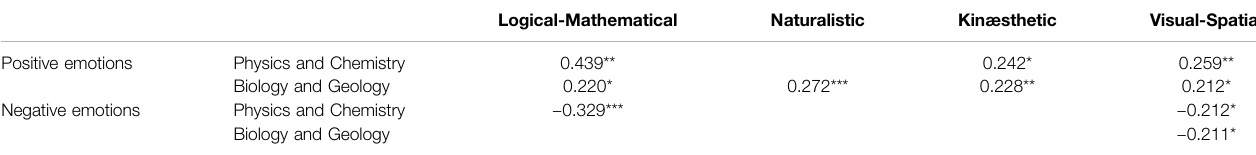
TABLE 3 | Spearman ’ s correlation coef fi cients between positive and negative emotions toward physics and chemistry and the different multiple intelligence pro fi